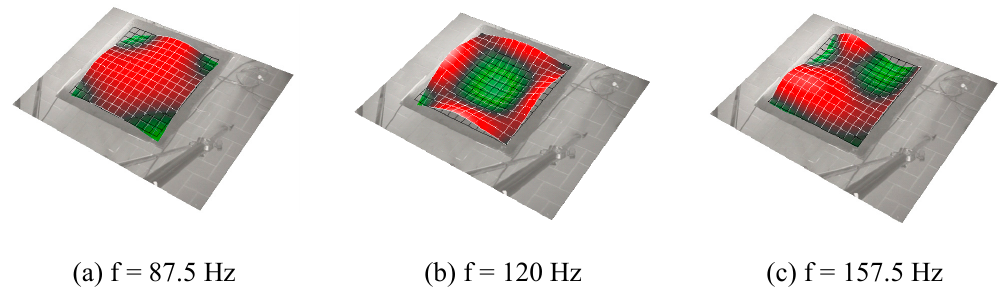
Figure 11. Operative deflection shapes of the composite panel.